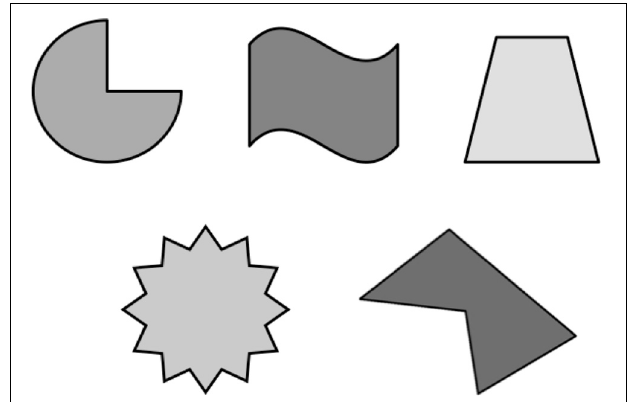
FIGURE 3 | Stimuli used for Experiment 1B. Not drawn to